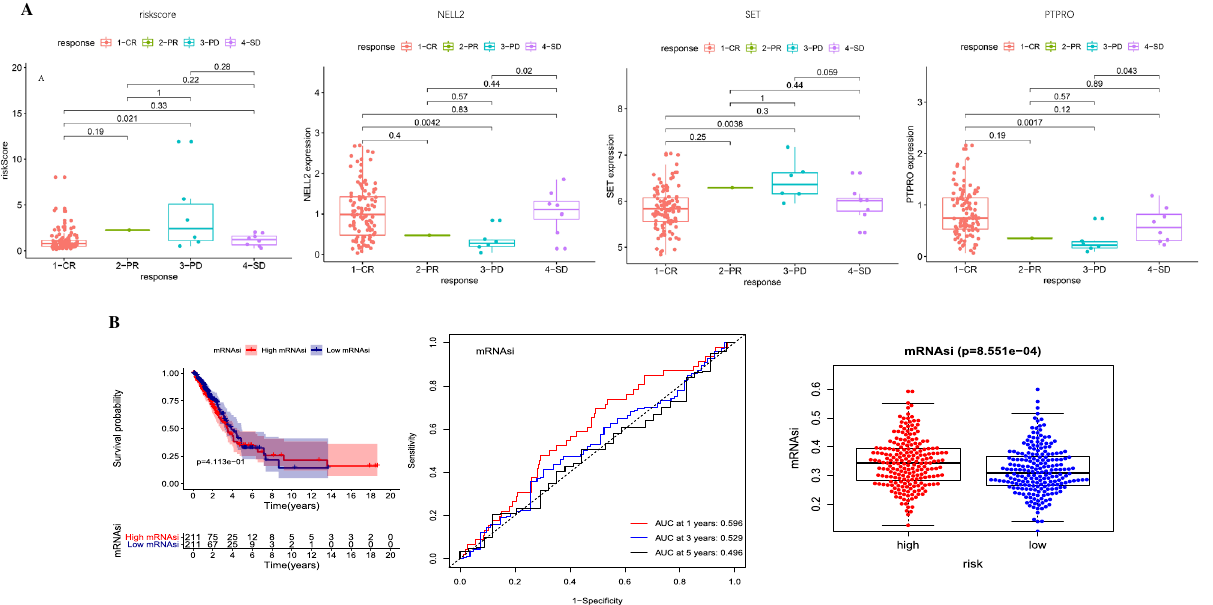
Figure 6. Analysis of therapeutic efficacy and correlation analysis of stem cell index. ( A ) Box plot suggests the links between the p-value of the difference between any two groups. ( B ) Kaplan–Meier survival, ROC curve, and box plot were used to demonstrate the risk prediction of signature-based on the stem cell index.